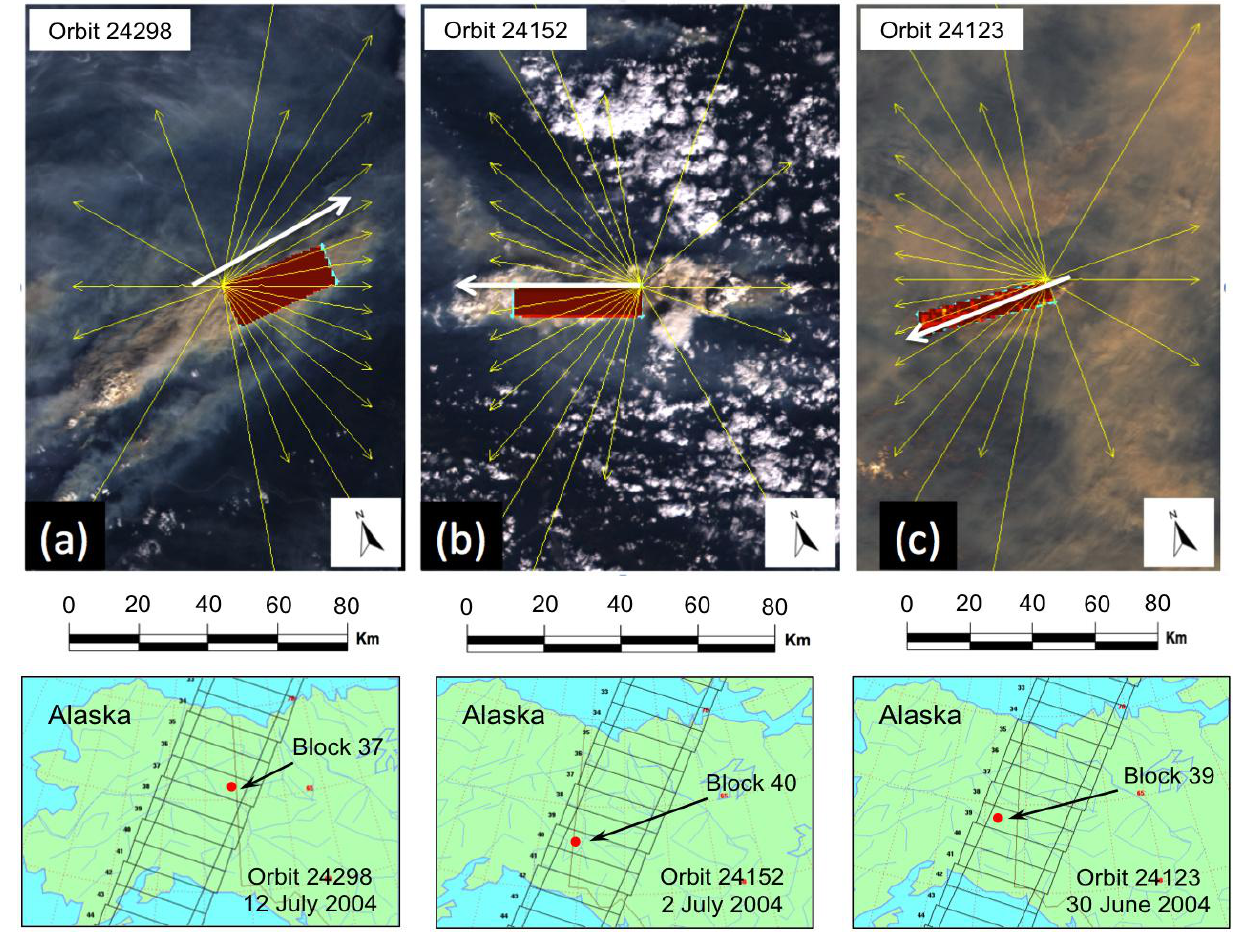
Figure 10. Large, flat-topped plumes used in tests of sensitivity of wind-corrected heights to digitized wind direction: ( a ) Smoke plume trending toward top right on orbit 24298, block 37; ( b ) smoke plume with only across-track component of motion on orbit 24152, block 40; ( c ) smoke plume trending toward bottom left on orbit 24123, block